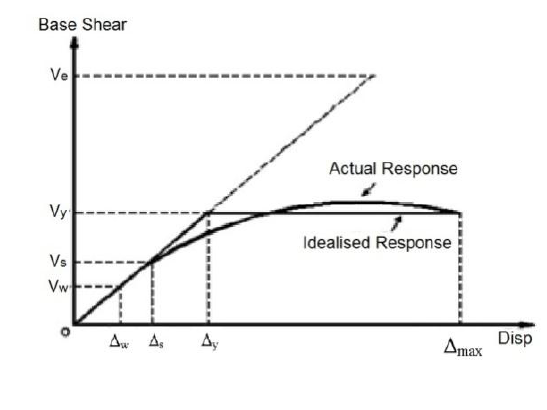
Fig. 6. General structural response (Uang CM,